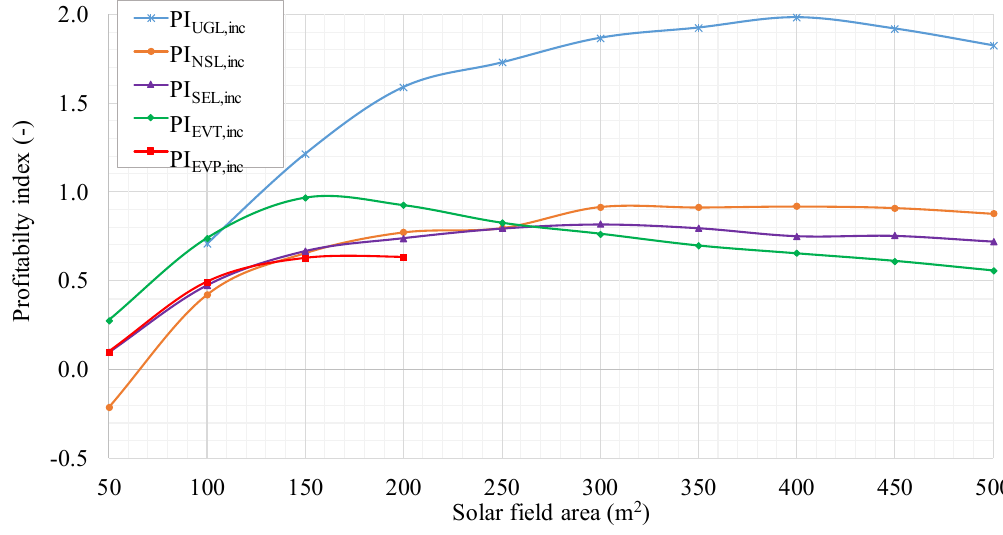
Figure 15. Profitability Index with incentive vs. solar field area, parametric analysis.